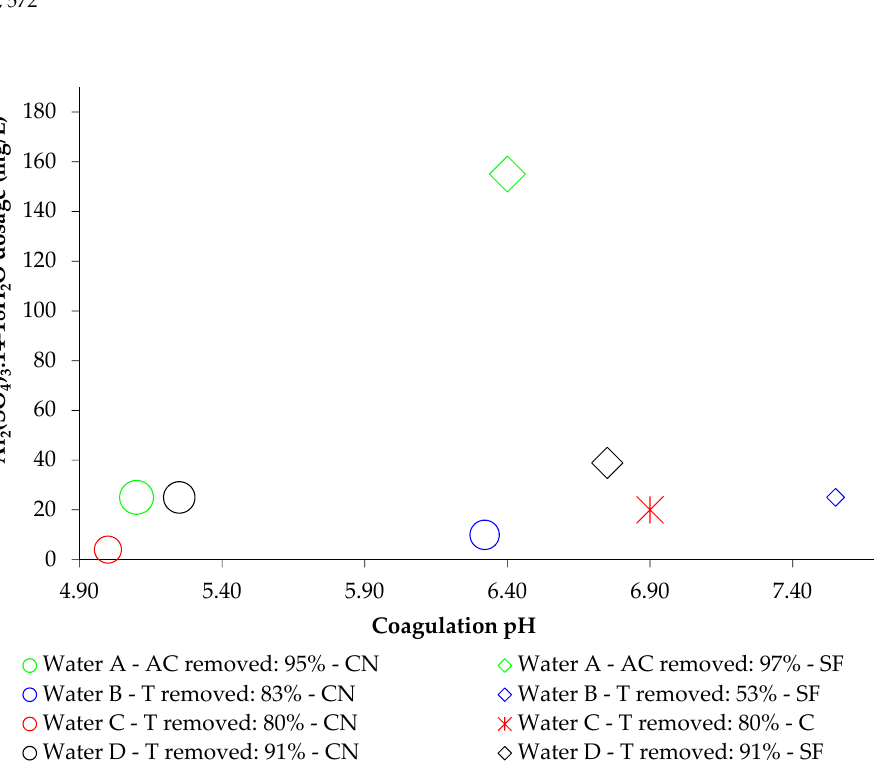
Figure 1. The selected points in the coagulation diagram represent removal efficiency in conventional Jar Test using synthetic water in the predominant mechanisms of coagulation, adsorption and charge neutralization (CN-circle), sweep flocculation (SF-rhombus) and combined (C-asterisk). Table 2. Characteristics of water samples in the adopted coagulation diagrams.